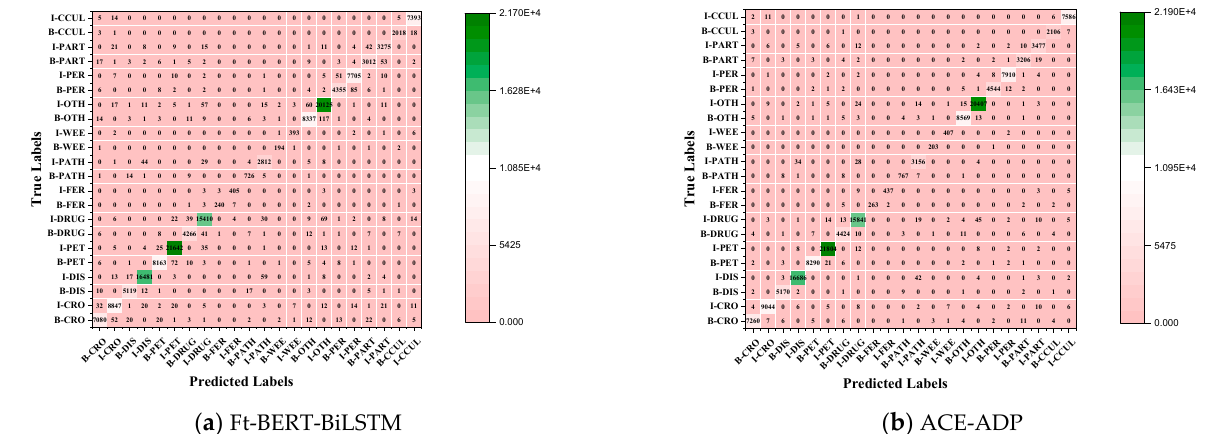
Figure 6. Confusion matrixes of ( a ) Ft-BERT-BiLSTM, and ( b ) ACE-ADP on AgCNER dataset. x -axis: predicted labels; y -axis: true-axis; numbers on the cell where x = y represents the TP values.